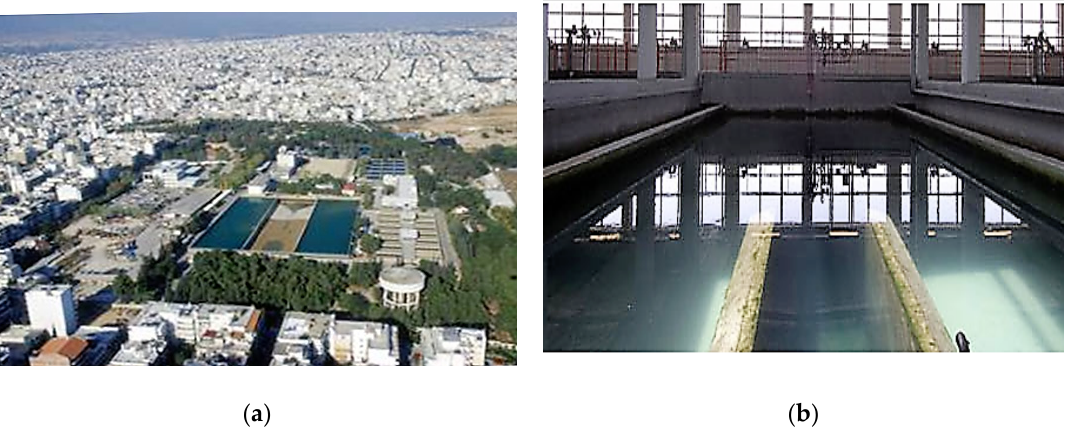
Figure 10. Greek WTPs: ( a ) In Galatsi Athens (Photo G. Stefanakou, EYDAP, Athens, Greece), and ( b ) the Thessaloniki Water Treatment Facility (Refinery) (www.eyath.gr, assessed 1/3/2022).